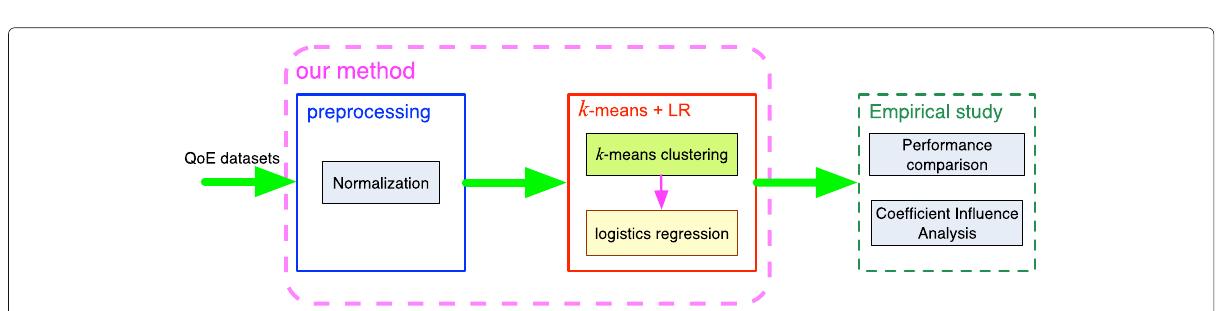
Fig. 5 Our method used in this